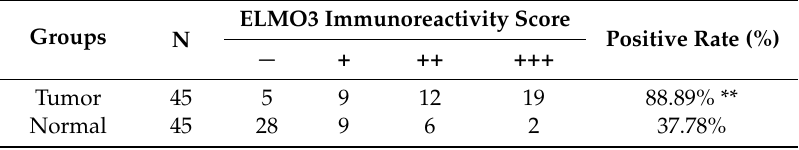
Table 1. Statistics of staining scores of ELMO3 in CRC tissues.